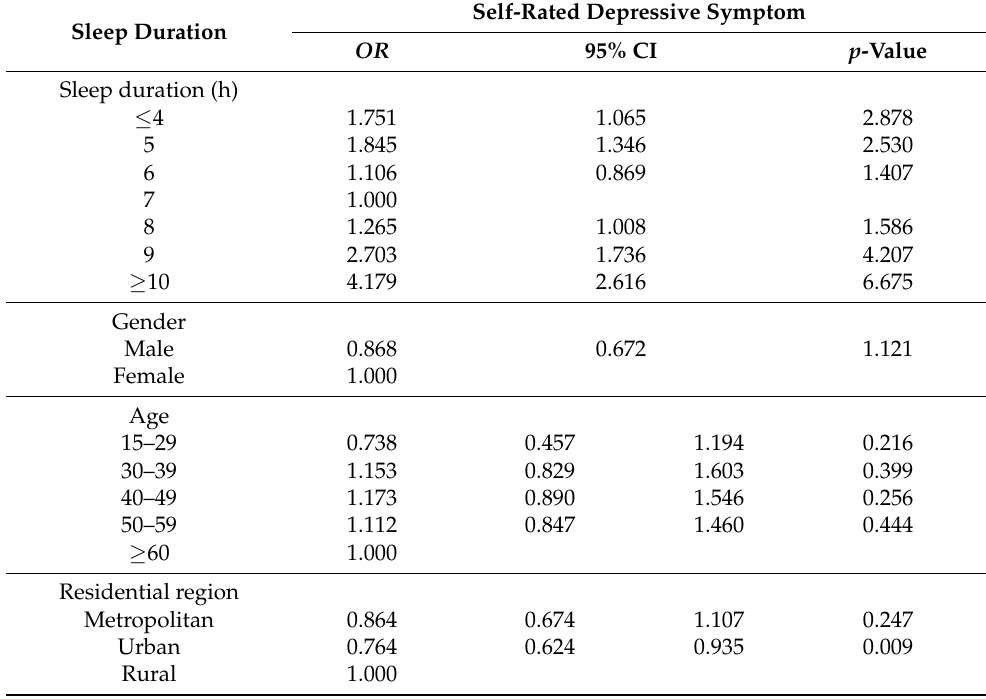
Table 2. The OR of self-rated depressive symptom among the people with physical